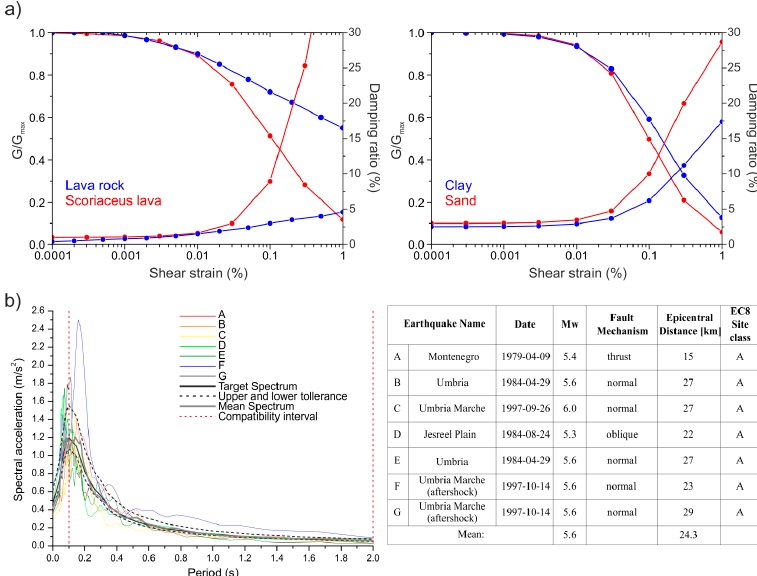
Figure 10. ( a ) Shear modulus (G) and damping factor (D) dependent on shear strain ( γ ) used in this study; ( b ) compatible combination of the acceleration response spectra (5% damping) found for the considered earthquake scenario.